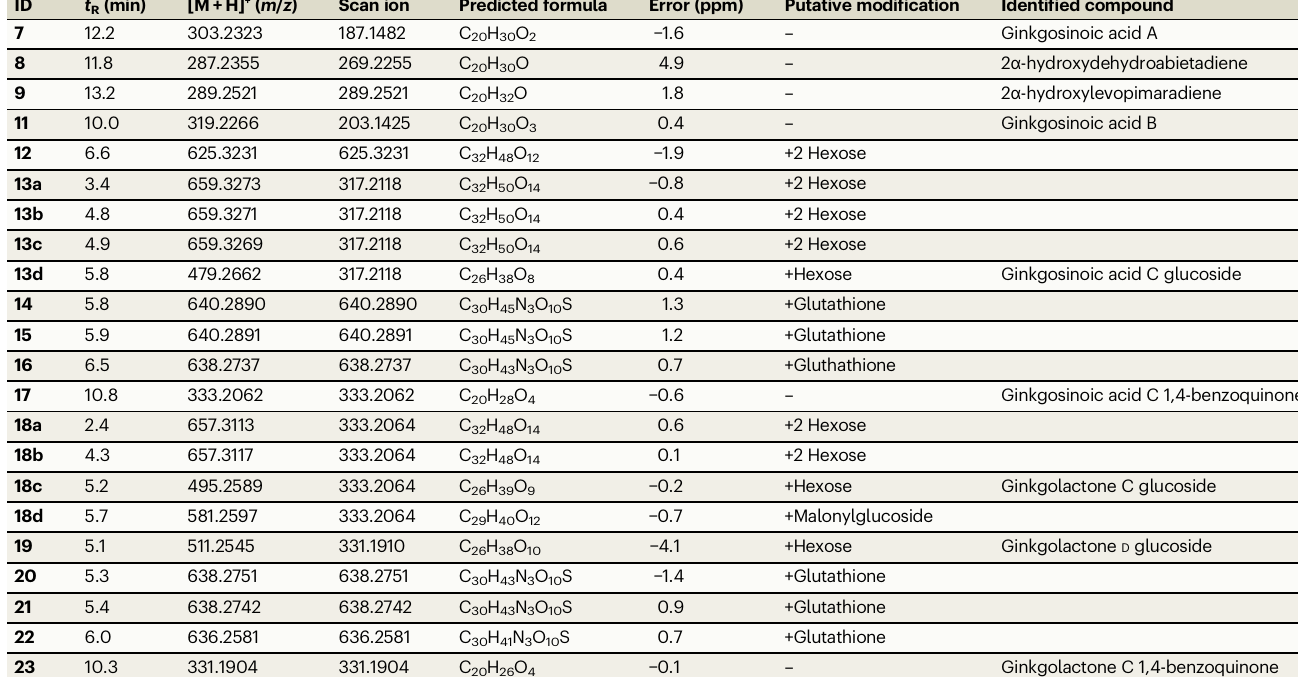
Table 1 | Products generated in this